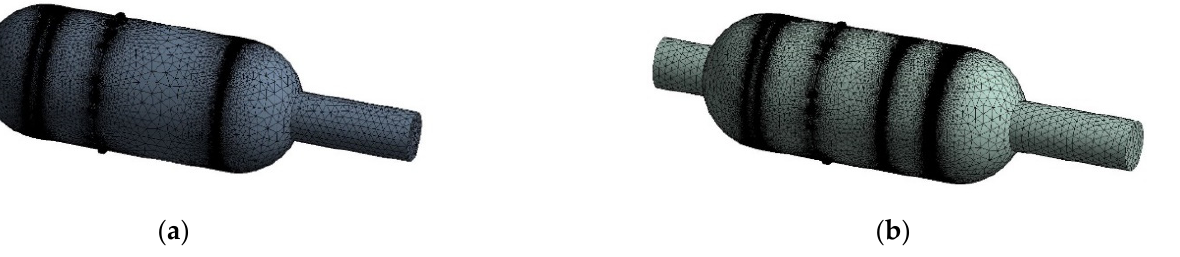
Figure 7. Meshing for two models. ( a ) Meshing without steady flow plates, ( b ) meshing with steady flow plates.